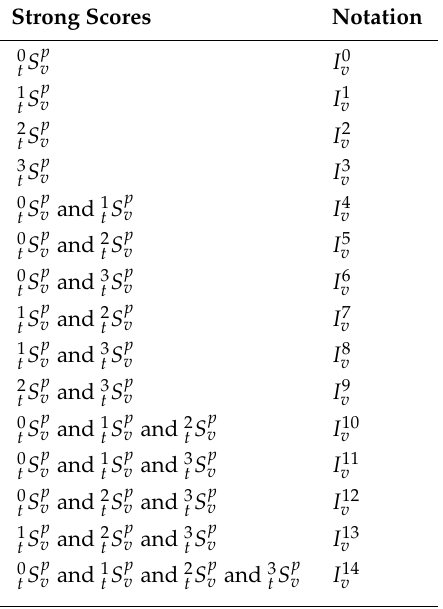
Table 1. Notation of scores.